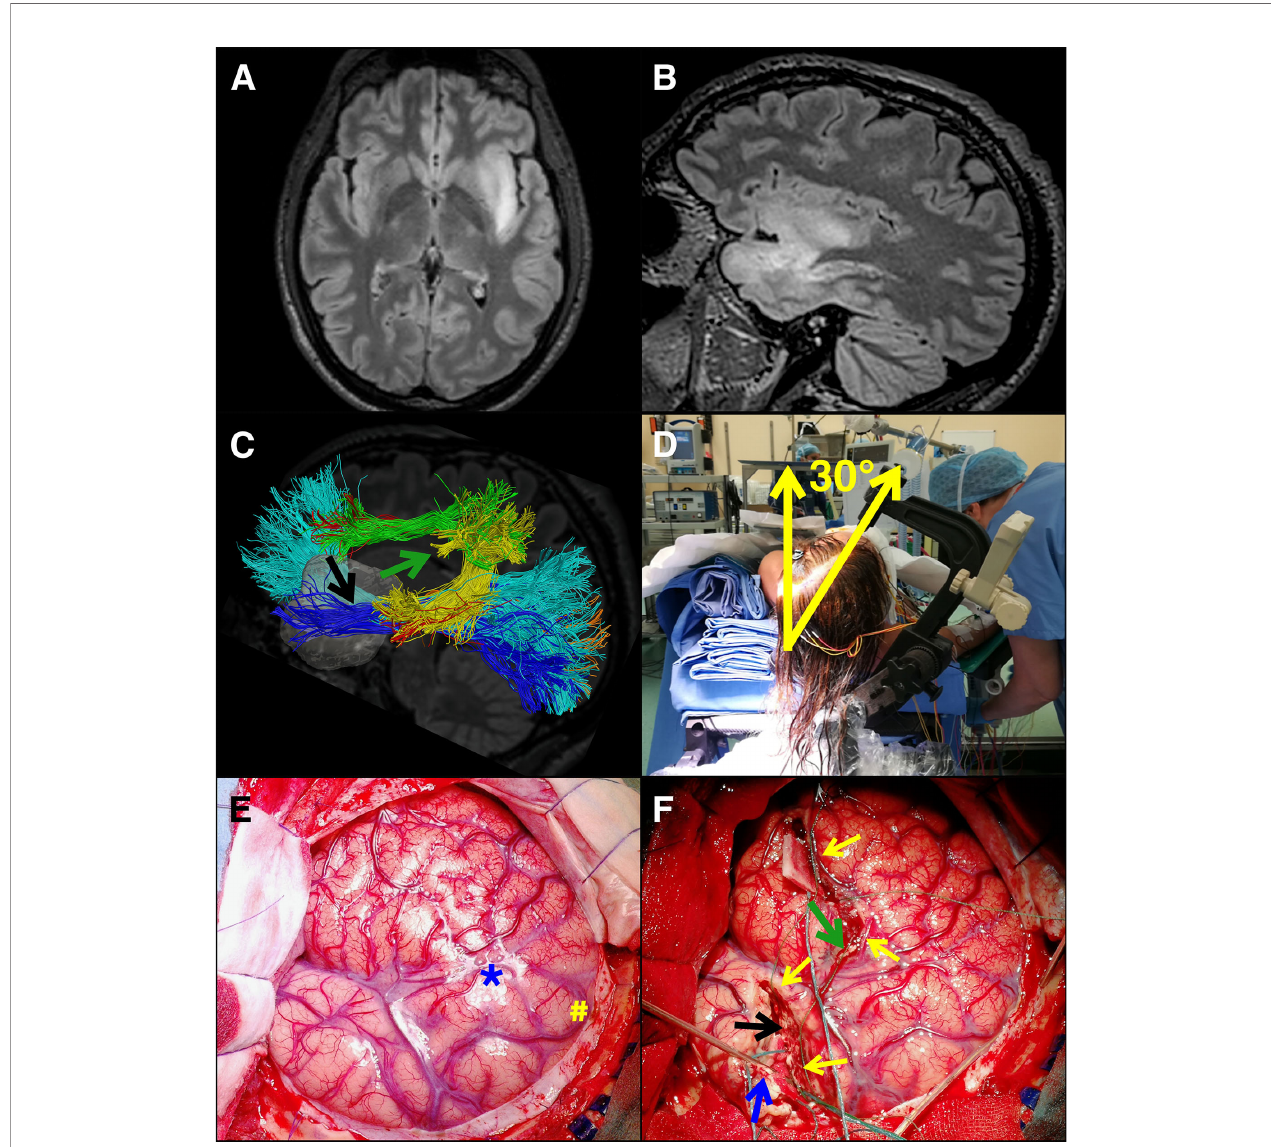
FIGURE 2 | Resection of a giant insular glioma in the dominant hemisphere. A young patient presented with sensory-motor seizures. She was submitted to MR, which illustrated a presumptive giant insular low-grade glioma in the dominant hemisphere. (A, B) Pre-op axial and sagittal, respectively, FLAIR images. Tumor volume was 42.5 ml. The patient was submitted to surgery under asleep-awake-asleep anesthesia and extensive cortical and subcortical mapping (motor, language, cognitive, haptic, visual) and neurophysiological monitoring (EEG, ECoG, MEP, SSEP). (C) HARDI – DTI map of the main tracts surrounding the tumor (Inferior- Longitudinal-Fasciculus is in blue , optic radiation in orange , Inferior-Fronto-Occipital-Fasciculus in cyan , Arcuate-Fasciculus posterior segment in yellow , AF long segment in red , anterior segment [Superior-Longitudinal-Fasciculus III] in green ). The two surgical corridors identi fi ed with the aid of brain mapping in the awake phase, also displayed in F, are highlighted by arrows ( green arrow , frontal corridor consisting in SLF III and AF long segment above, and A474 F posterior segment posteriorly; black arrow , temporal corridor consisting in ILF inferiorly and posteriorly, IFOF and optic radiations superiorly and posteriorly). (D) intraoperative picture of the patient positioned supine with the shoulder elevated of 30° and the head tilted of 30° toward the tumor opposite side. (E) intraoperative picture of the large bone fl ap designed to expose the tumor area and the functional landmarks to be identi fi ed during the awake phase (M1 and vPM, in the picture marked with # and * respectively). (F) Intraoperative picture taken at the end of the awake phase, where the corticectomy on frontal and temporal opercula is visible, along with the posterior functional margin of the resection (secured by patties and indicated by yellow arrows ). Subcortical identi fi cation of functional boundaries and functional disconnection of the frontal and temporal lobes and superior insula was performed by subcortical mapping; surgical patties were placed to indicate these boundaries (arrows). A monopolar probe was placed to indicate the temporal resection posterior border (indicated with a blue arrow ). The use of extensive mapping allowed the identi fi cation of two surgical corridors, the fi rst in the inferior and posterior margin of the frontal lobe (green arrow) and the second in the superior and posterior margin of the temporal lobe (black arrow). This approach, along with head positioning tilted of 30°, guaranteed optimal surgical access to the superior and inferior portions of zone II (frontal corridor, green arrow) and III (inferior corridor, black arrow), allowing to resect the tumor in these areas without damaging functional (visuospatial, cognitive and language sites). Final tumor removal was then performed under motor mapping (by HF) and continuous MEP-SEP recordings. Histo-molecular diagnosis revealed a grade II